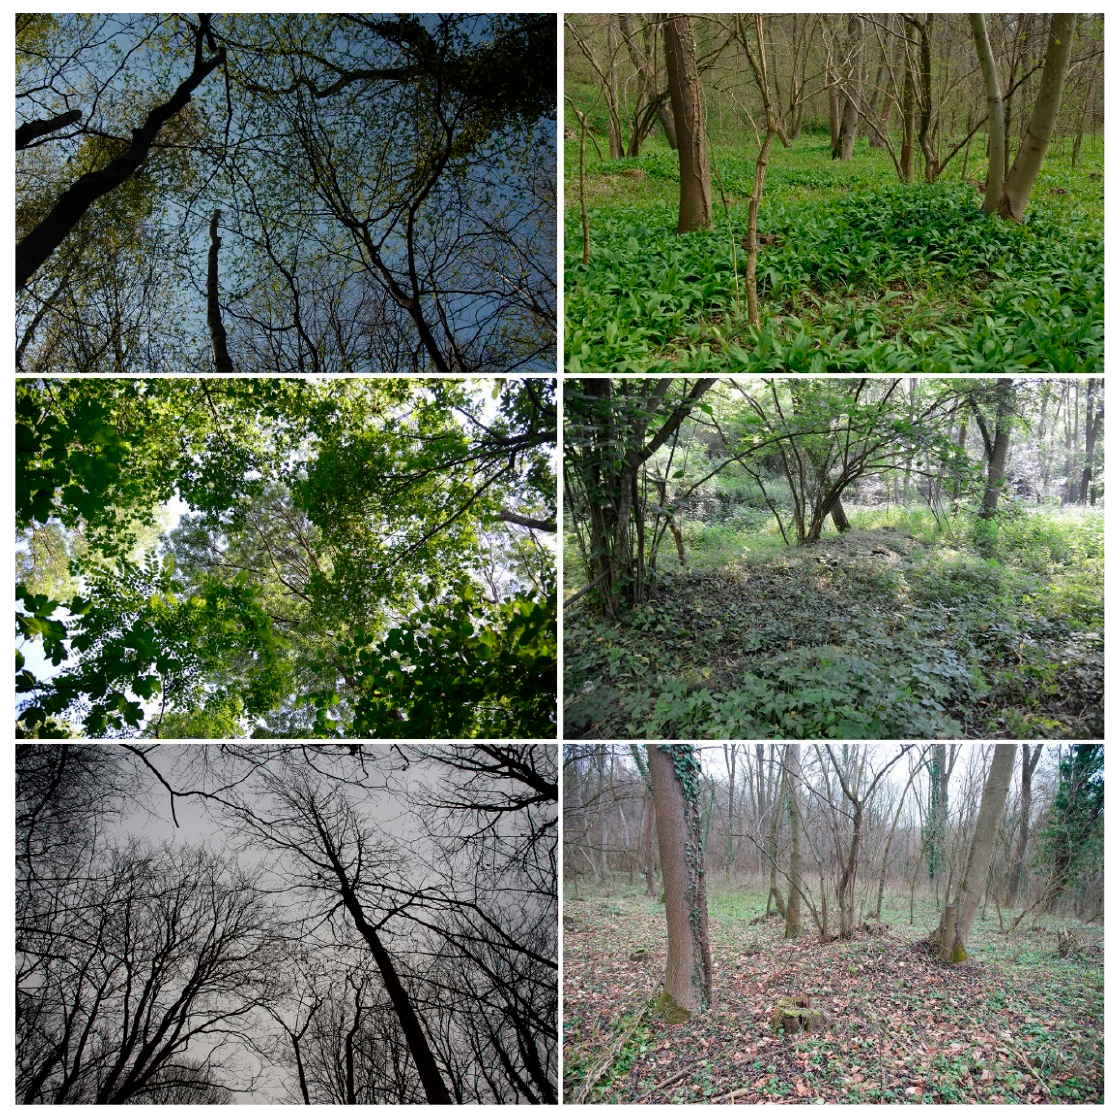
Figure 4. On-site photographs. Upper row : Spring 2007; middle row: June 2013; lower row : November 2013 (photographs by M. Doneus).